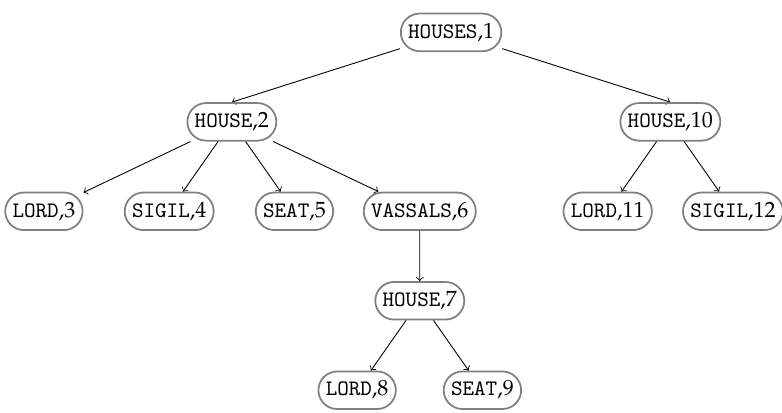
Figure 1. XML tree model T ( D ) from Example